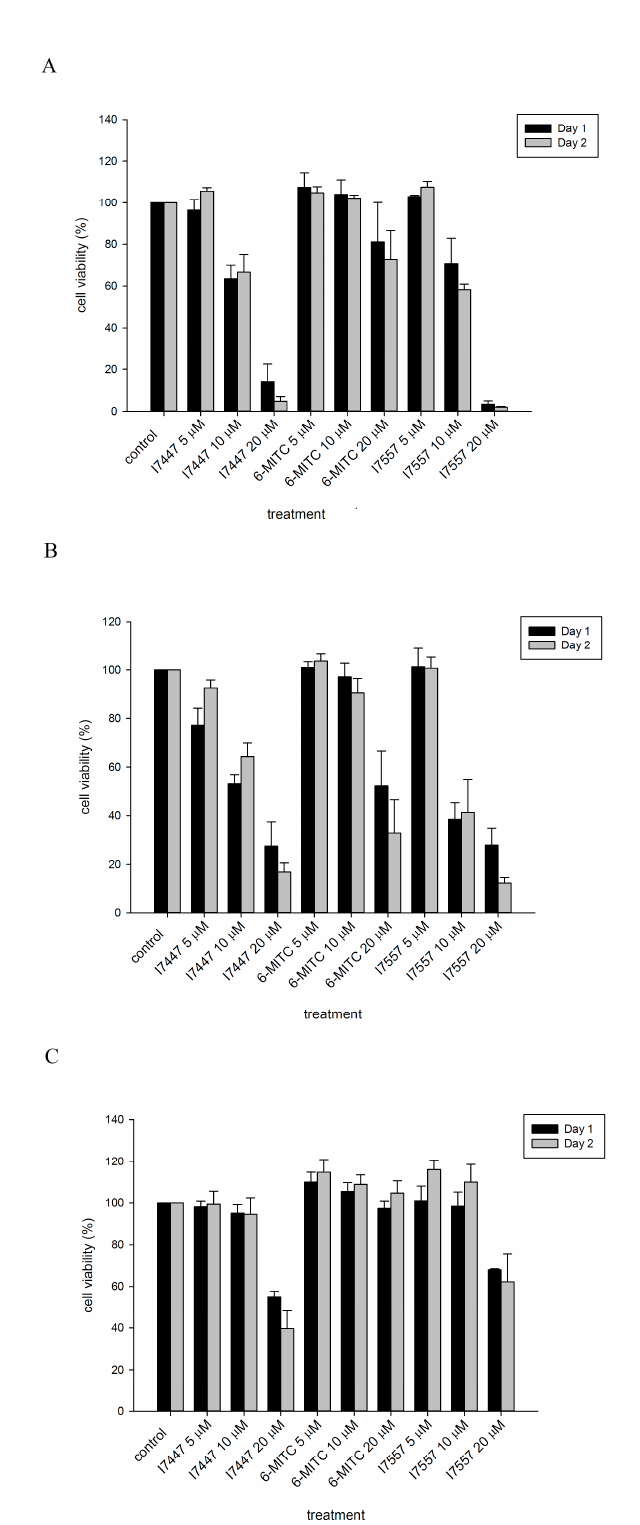
Figure 2. Cell viability of human oral cancer and normal human fibroblast (HFW) cells. The human oral squamous cells, carcinoma SAS ( A ) and OECM-1 ( B ), and HFW cells ( C ) were treated with 6-MITC, I7447, or I7557 for 24 and 48 h. Cell viability was measured using MTT assay. Data from three separate experiments were expressed as the mean ± SEM.